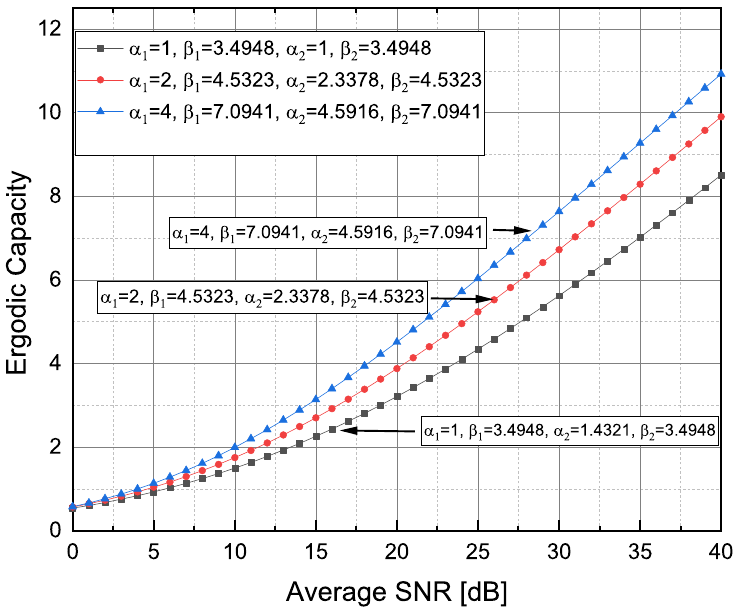
Figure 5. Ergodic capacity versus ¯ γ th observed for different TI fading severity